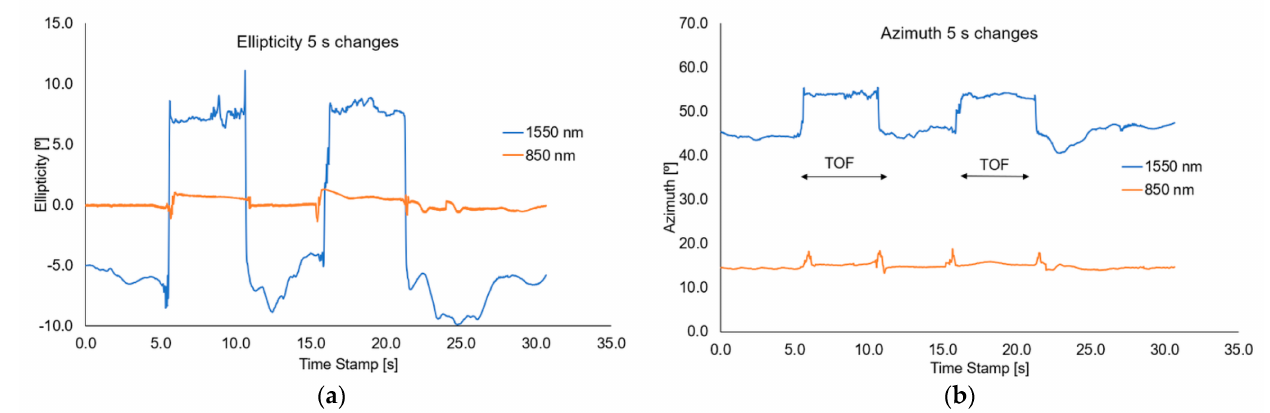
Figure 16. Graphs of influence of sliding the magnetic mixture on change the ellipticity ( a ) and azimuth ( b ) for a rapid sweep of magnetic field for wavelengths of 850 nm and 1550 nm.